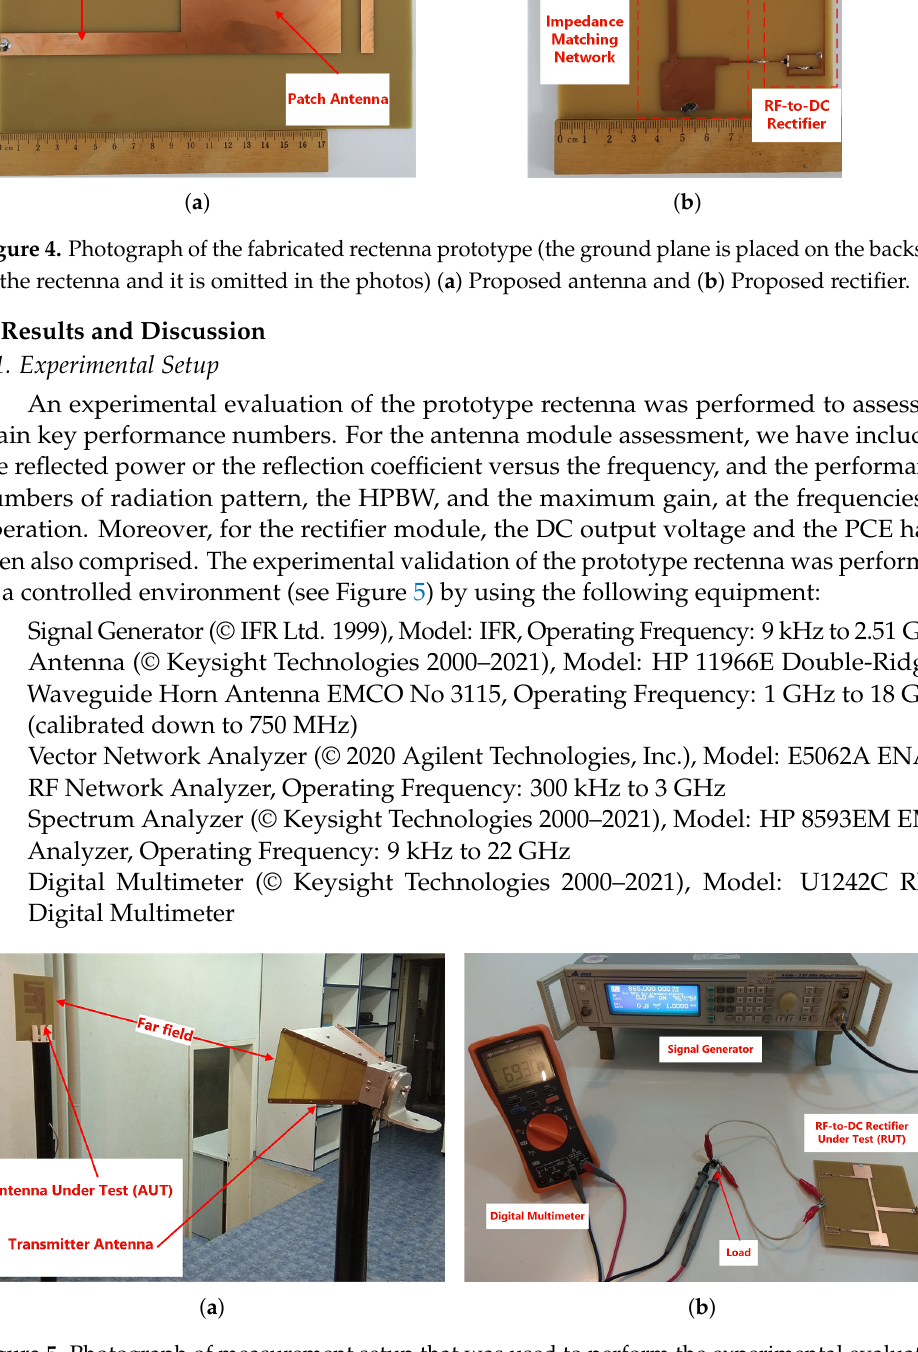
Figure 5. Photograph of measurement setup that was used to perform the experimental evaluation of the fabricated rectenna ( a ) Measurement setup for the proposed antenna and ( b ) Measurement setup for the proposed